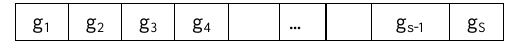
Fig. 2. The structure of a chromosome for inner GA